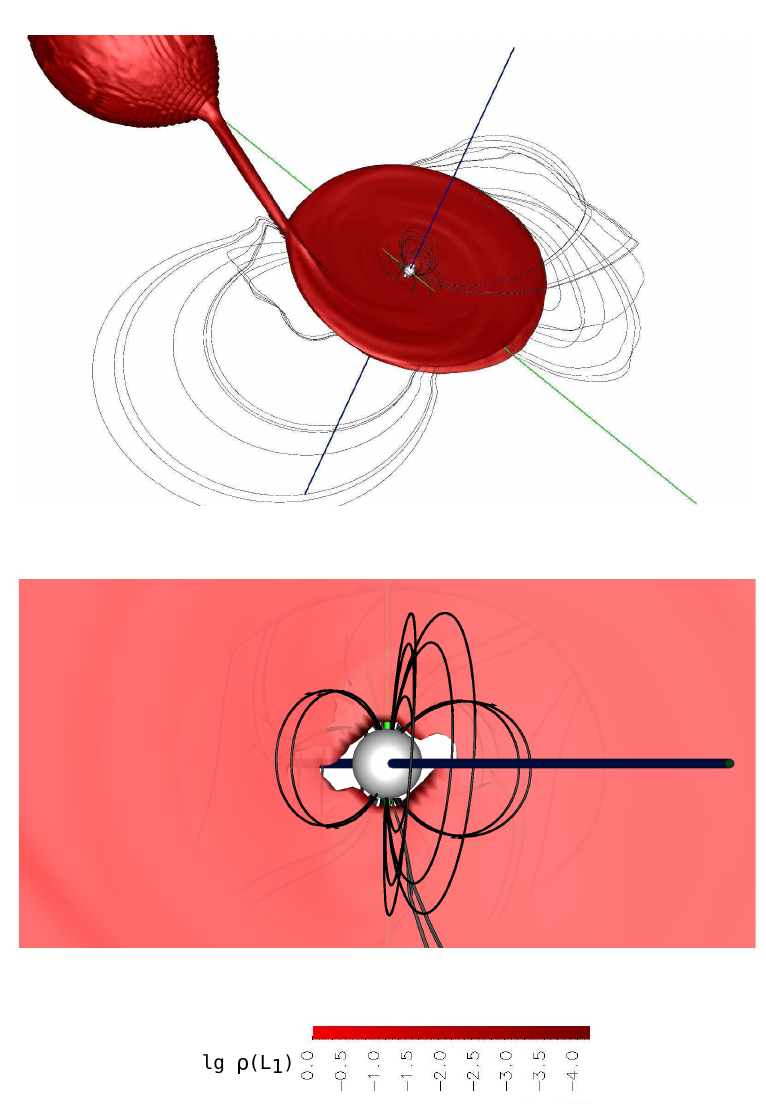
Figure 3. The result of three-dimensional numerical modeling of the flow structure in the intermediate polar EX Hya. The iso-surfaces of the decimal logarithm of the density in units of ρ ( L 1 ) are shown. The accretor is represented as a white sphere. The blue vertical line passing through the accretor coincides with its axis of rotation, and the green line coincides with its magnetic one. Black lines with the arrows indicate the magnetic field lines. The upper panel shows a general view of the system, the lower panel represents an accretion area near the surface of white